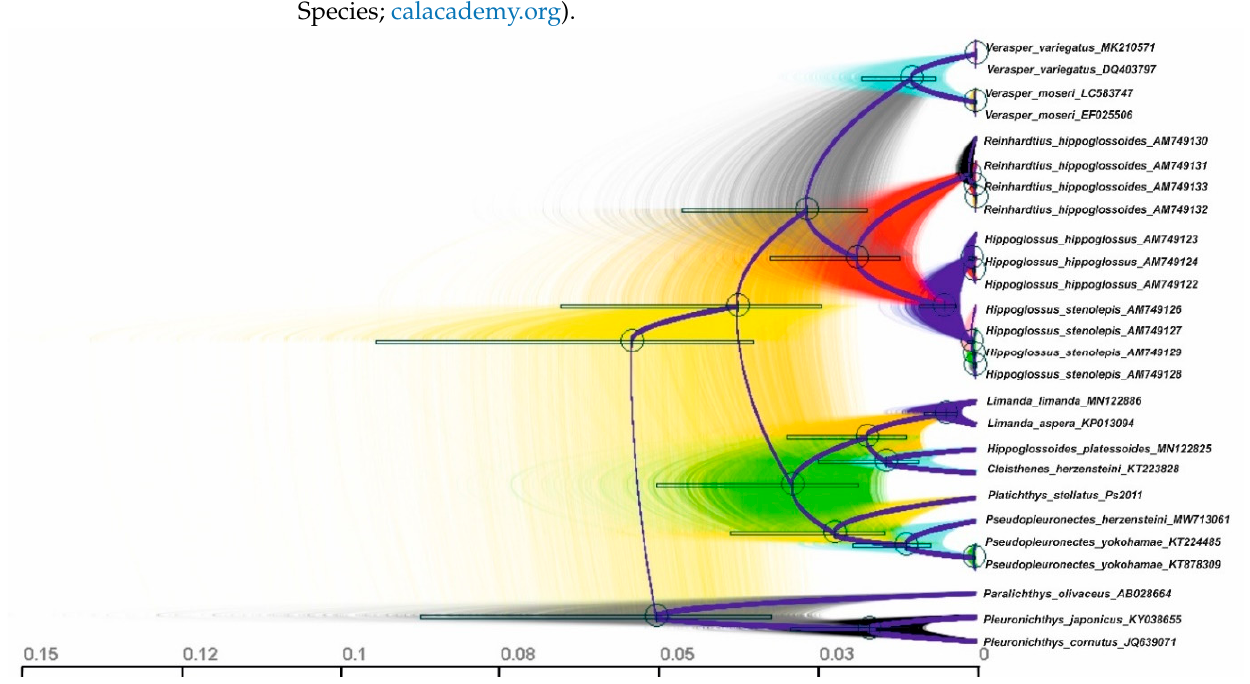
Figure 6. Phylogenetic lineages reconstructed via BEAST-2 and visualized with DensyTree software based on 26 sequences of 13 PCGs of the flounder family Pleuronectidae. Simulated lineages are naturally rooted in three presumed ancestral taxa including the predefined outgroup taxon Par- alichthys olivaceus . Wider violet lines depict the consensus trees constructed by computer simulations of coalescent process of molecular evolution in constant populations during 5 × 10 7 generations by BEAST-2 as explained in detail in the Results and in the above paragraph in the main text. Thin lines show all possible trees that occurred during the time span as depicted in the scale given in node ages. DensyTree reconstructed time-tree interrelationships based on the same BEAST run and the output tree file as that used for building Figure 4. Source tree file available for use from Table S3, Supplement (File: Fl26seq-pt8-11401-123ps4.trees). Bars represent CA 95%HDP for the node ages. Circles with a dot inside show the support area and averages for clades. The main branches are stained with different